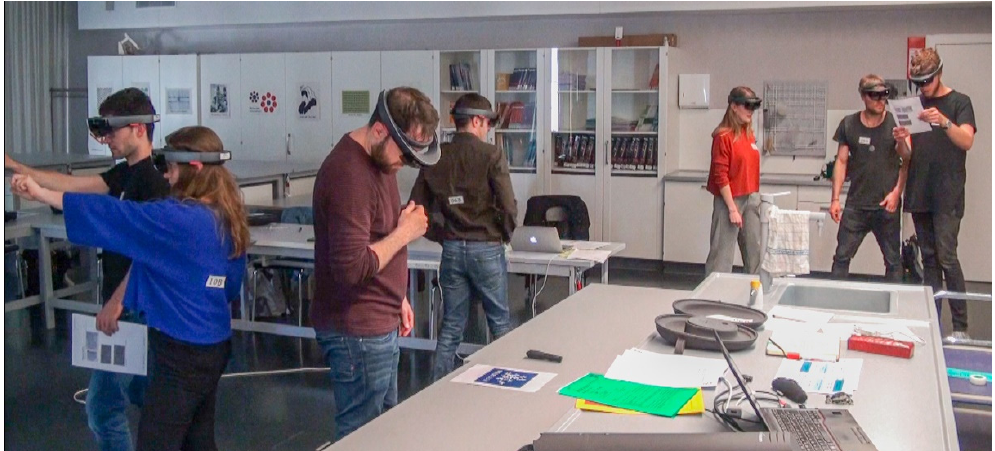
Figure 2. Collaborative work phase with HoloLens (for more information on the content and structure of the teaching unit see [30]).